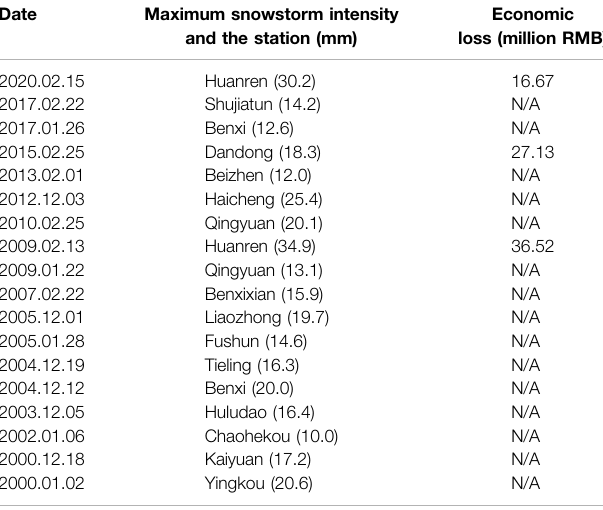
TABLE 1 | The snowfall episodes and their impacts in 2000 – 2020.